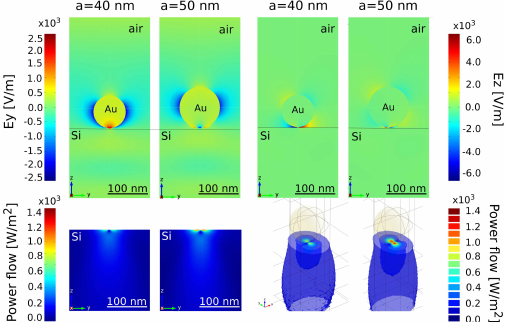
Figure 2. Electromagnetic field distribution and power flow around a single gold nanoparticle. The incident wavelength is set to λ = 500 nm. ( upper panel ) E y and E z components of the electromagnetic field near the Au NP deposited on the top of a Si substrate calculated for NP radii 40 and 50 nm. ( lower panel ) The time averaged electromagnetic power flow to the Si substrate in side and top